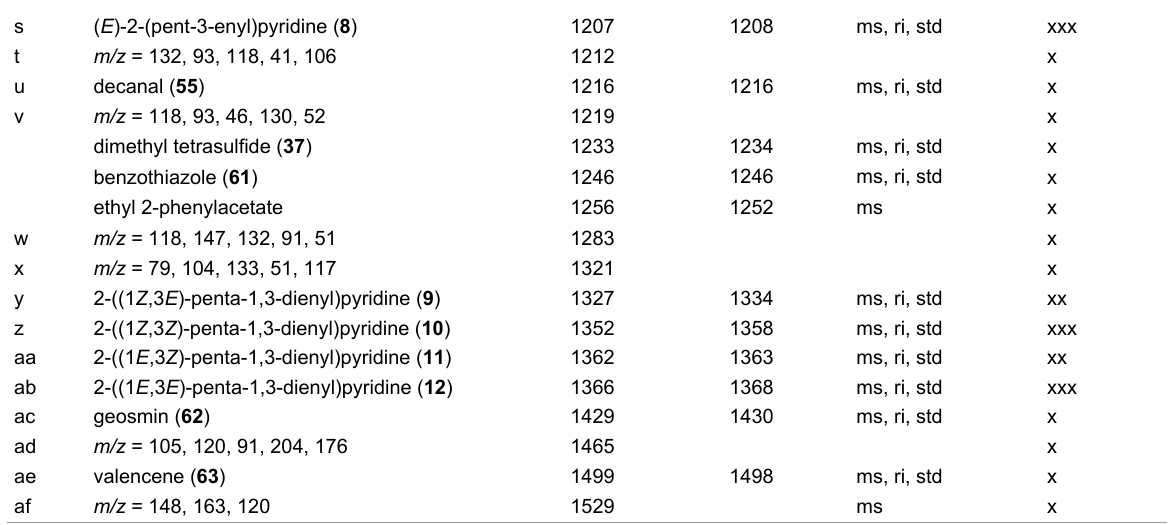
Table 1: Volatile compounds identified in the headspace extract of Streptomyces strain FORM5. The amounts of the compounds are given as 0–2% (x), 2–8% (xx), >8% (xxx) relative to the largest peak area in the total ion chromatogram. The identification of the compound based on comparison of mass spectrum to a data base spectrum (ms), comparison of retention index to a published retention index on the same or similar GC fused silica capillary column (ri), and/or based on comparison to a synthetic or commercially available reference compound (std).